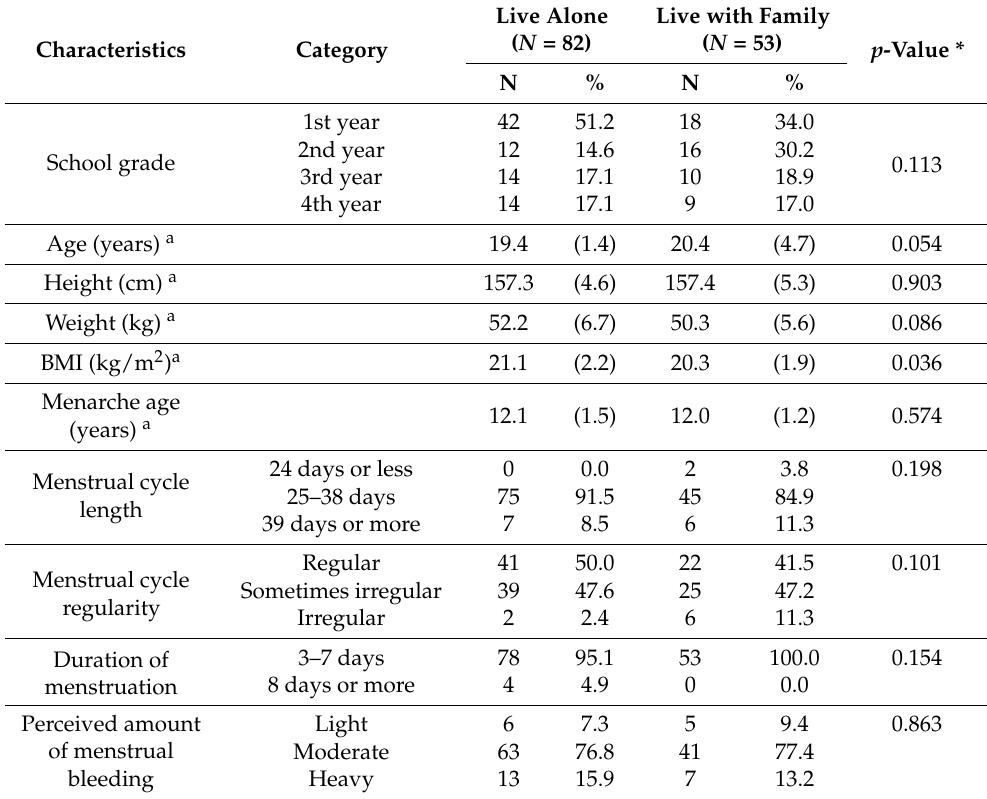
Table 1. Demographic characteristics and menstrual conditions depending on living status.